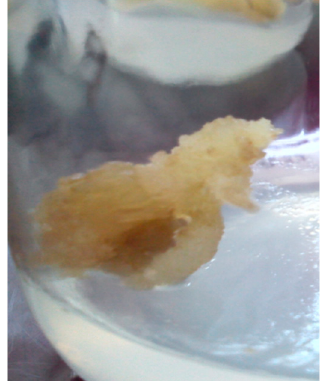
Figure 1. G. max callus forming on an explant.